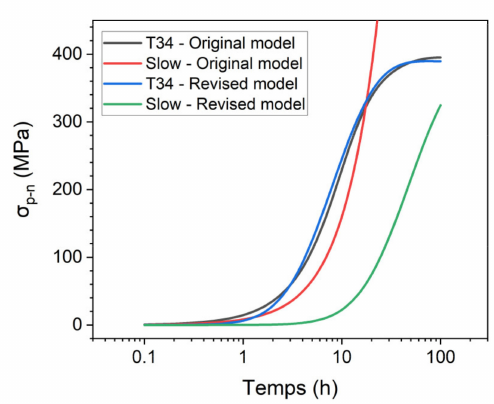
Figure 11. The evolution of the simulated strength contribution of the T 1 precipitates during artificial aging at 155 ◦ C. Comparison between the original [9] and revised model for the T34 state and an arbitrary slower kinetics of